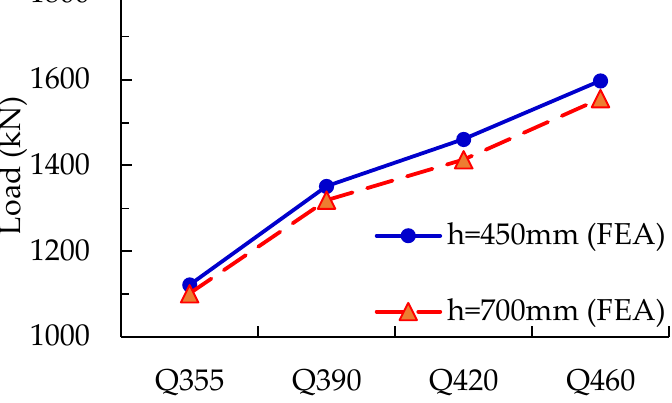
Figure 22. Comparisons of different lengths and strengths of the columns.